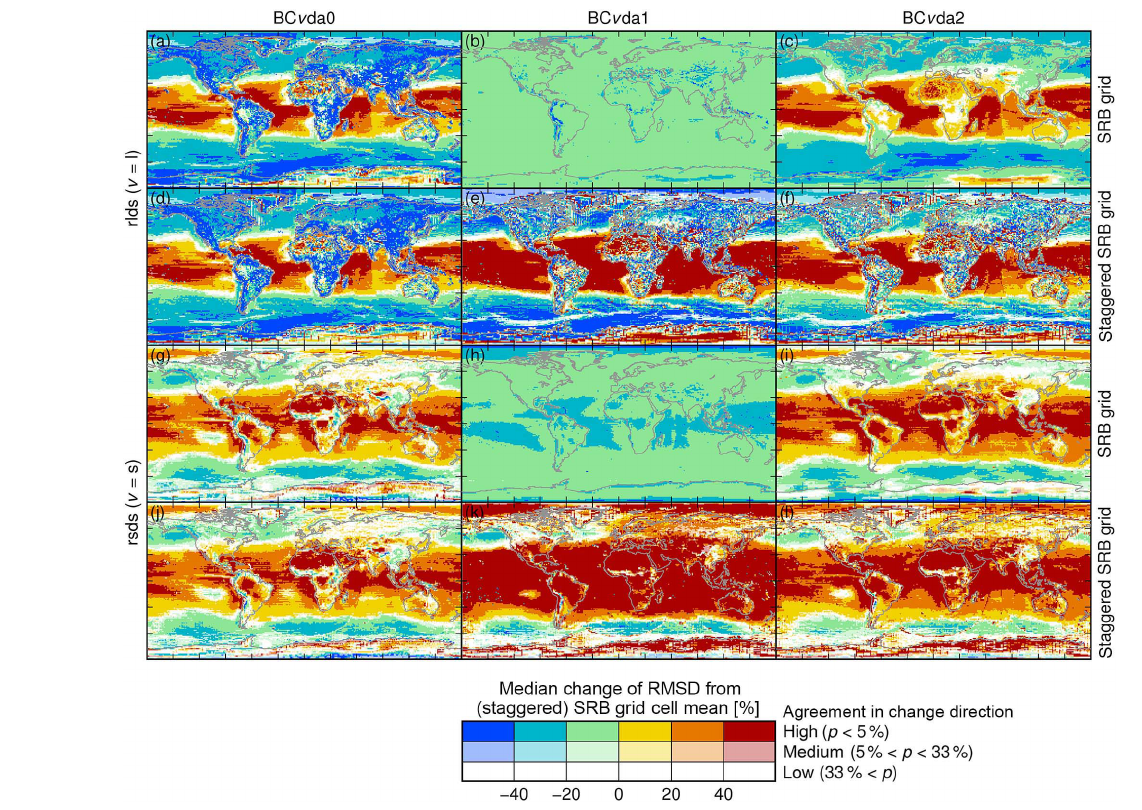
Figure 7. Relative change by bias correction with methods BC v da0 (left), BC v da1 (middle), and BC v da2 (right) of the root-mean-square deviation (RMSD) of daily mean E2OBS-grid-scale longwave ( a – f ) and shortwave ( g – l ) radiation from the aggregated SRB-grid-scale values based on 1 ◦ grid cells of the SRB grid ( a – c , g – i ) and the staggered SRB grid ( d – f , j – l ; see text). For every 1 ◦ grid cell and calendar month, the RMSDs are calculated using original or bias-corrected E2OBS data from the four 0.5 ◦ grid cells contained in the 1 ◦ grid cell, pooling data from the entire December 1983–November 2007 time period and omitting shortwave radiation data from months with average rsdt less than 1Wm − 2 . Depicted are median and agreement in the direction of monthly RMSD changes by bias correction (same colouring scheme as in Fig. 2). Very similar results are obtained for the corresponding basic bias correction